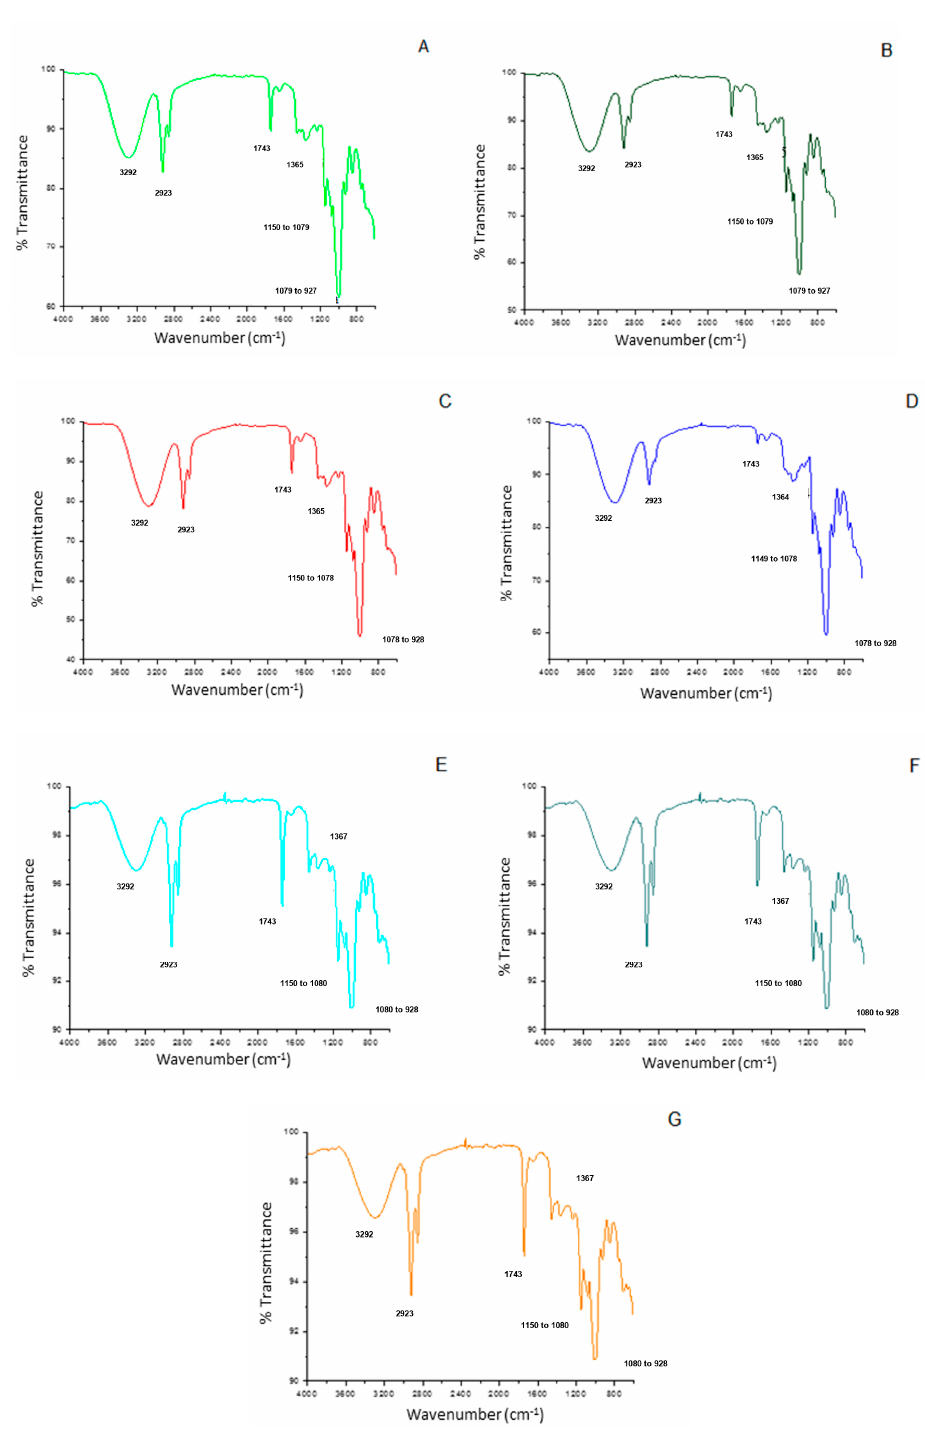
Figure 5. Fourier transform infrared spectra of the cassava starch-based films incorporated with buriti oil. The letters ( A – G ) correspond to the seven film-forming solutions prepared according to the coded and real levels from Table 1.